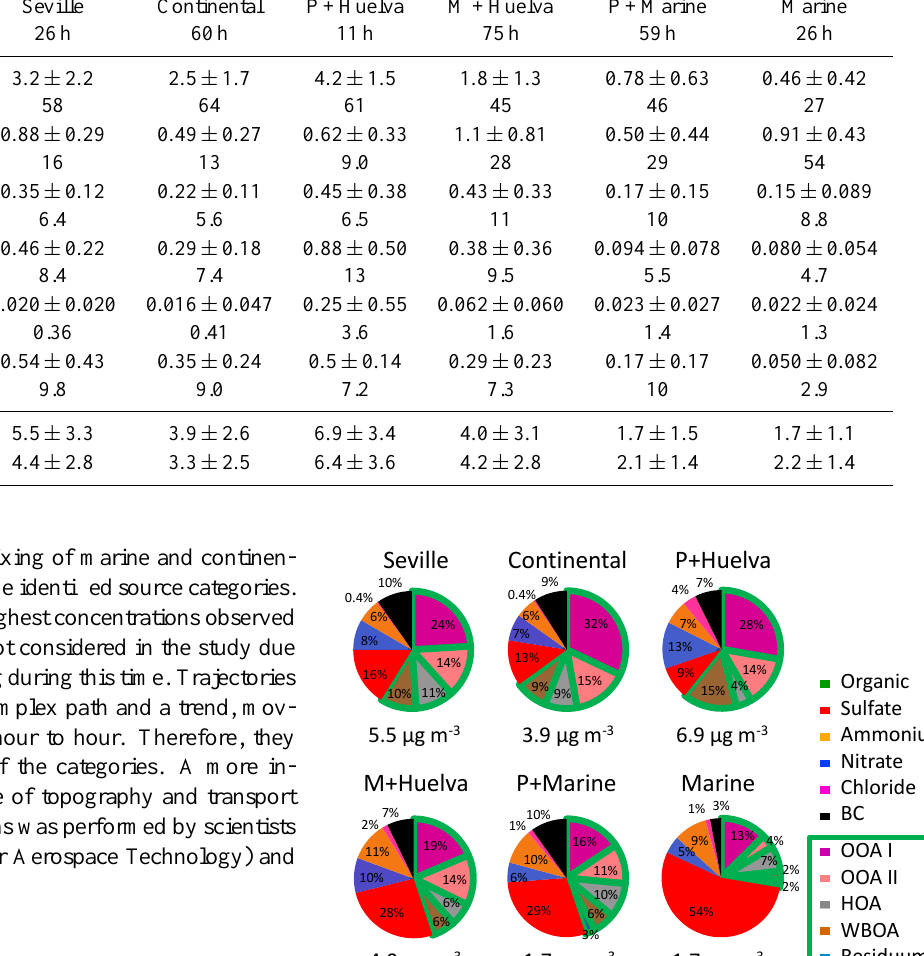
Table 2. Averaged submicron mass concentrations and fractions of total PM 1 for the common HR-ToF-AMS species and black carbon within the categorized air masses. For each category the total time of measurements is listed that are used for the evaluation. For each species, standard deviations are listed as an estimate for the inner-category variability. Seville